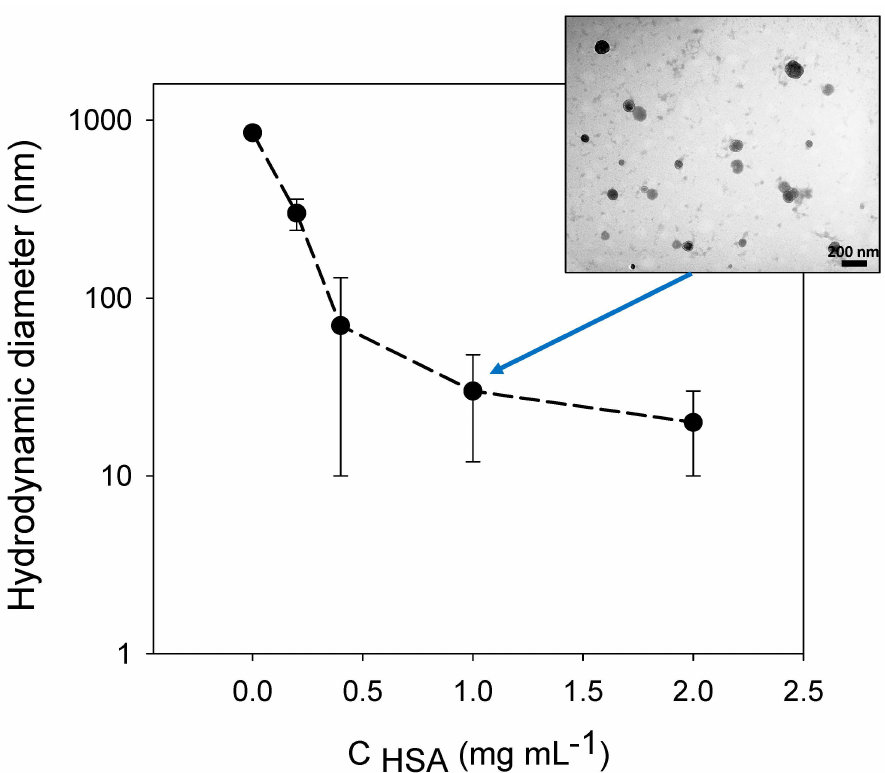
Figure 4. Variation of the hydrodynamic diameter of polydopamine (PDA) particles, as measured by dynamic light scattering; with the concentration of human serum albumin (HSA) added in the dopamine solution (10.6 mM in the presence of 50 mM Tris buffer at pH = 8.5). Dopamine has been oxidized with dissolved O 2 (open vessel) for 24 h at room temperature before the measurement. Reprinted from [52], Copyright (2014), with permission from Elsevier. The inset (personal data from the author) represents a transmission electron micrograph of the PDA suspension obtained in the presence of HSA at 1 mg mL − 1